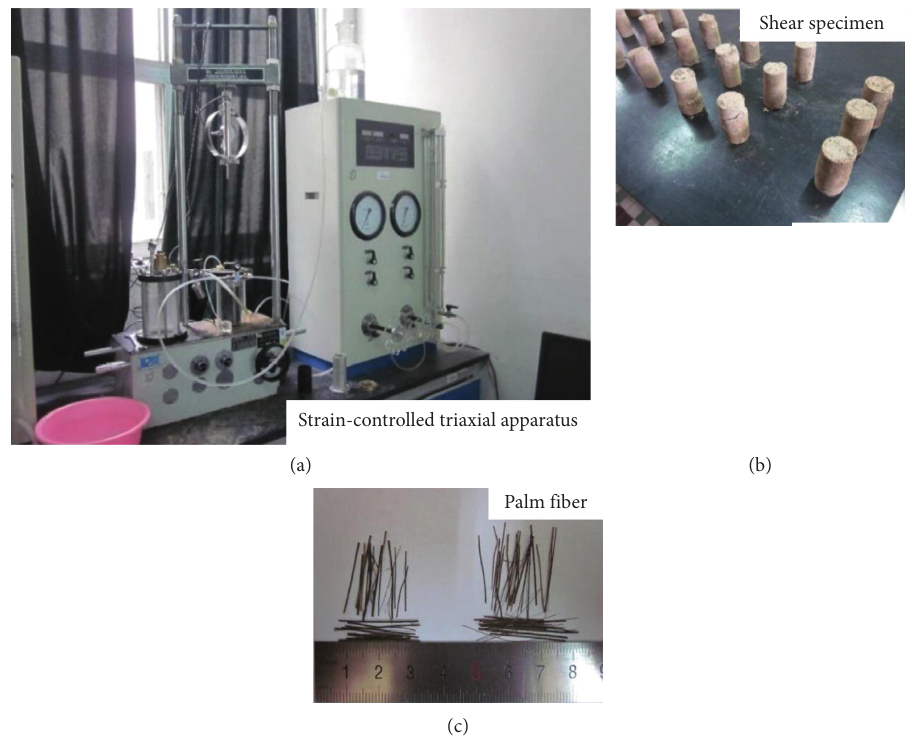
Figure 2: Test instrument and shear specimen.